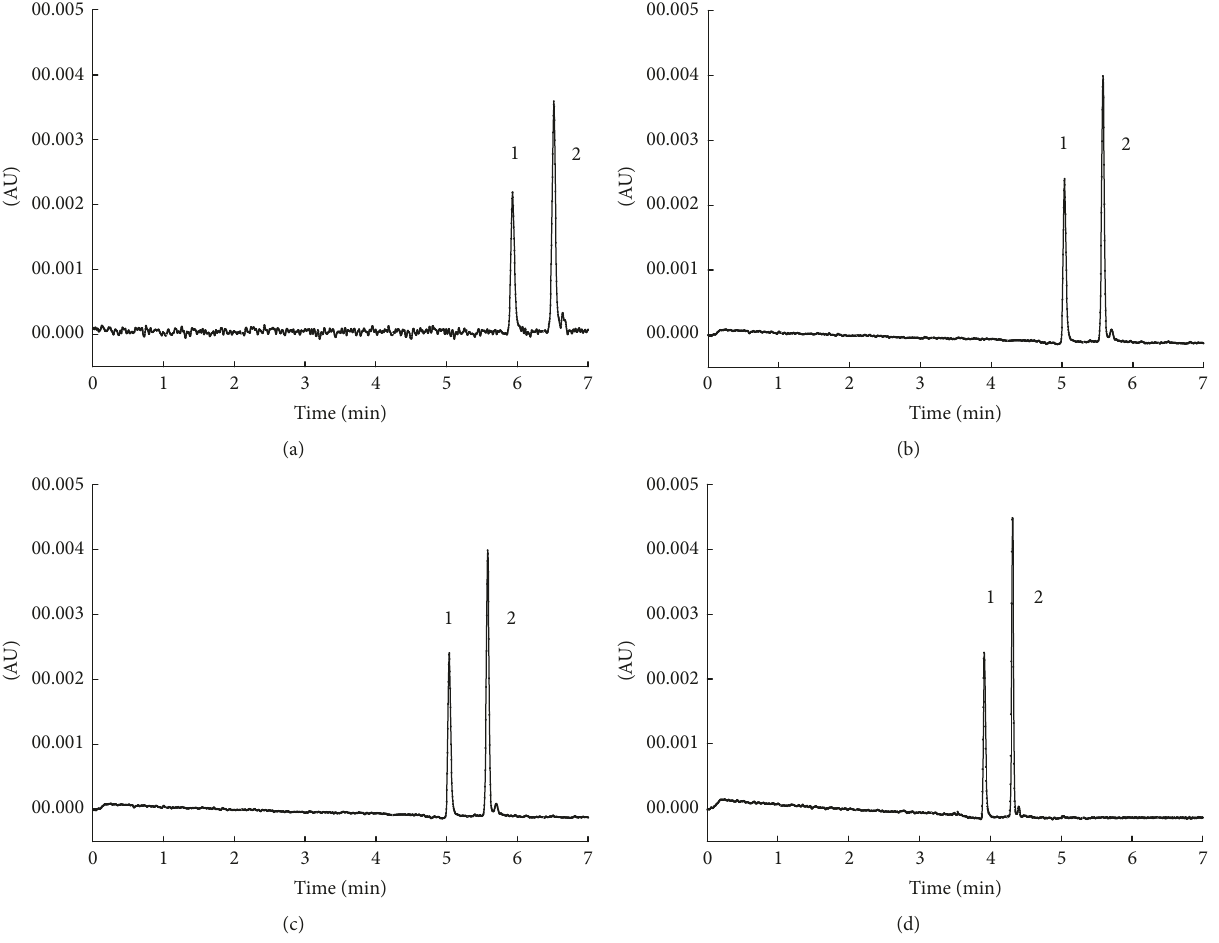
Figure 4: Effect of different separation voltage on the separation. Chromatogram identification: (a) 17 kV; (b) 20 kV; (c) 22 kV; (d) 25 kV. Separation conditions and peak identification were as in Figure